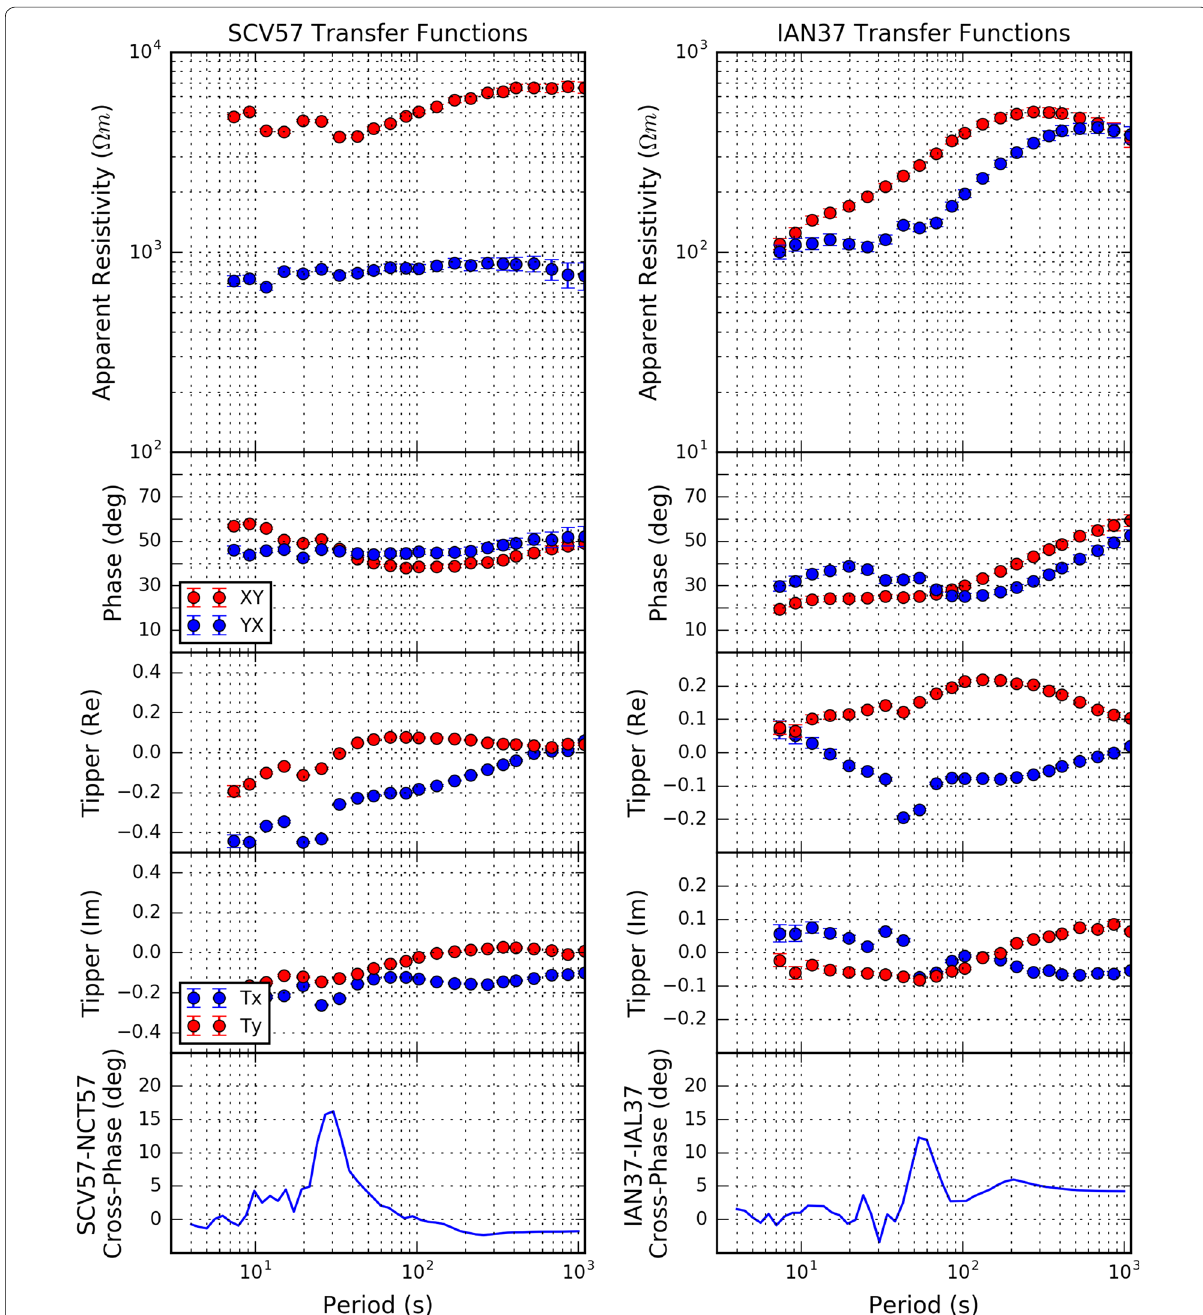
Fig. 2 Transfer functions and cross-phase analyses from sites shown in Fig. 1. The upper four plots in each column display the robustly estimated remote reference TFs for the indicated site. TF estimates were calculated with EMTF (Egbert and Booker 1986). In each of these plots, blue is used to denote TFs that involve the N–S magnetic field (X geomagnetic component: YX impedance element and Tx vertical field TF component) and red is used to denote TFs that involve the E–W magnetic field (Y geomagnetic component: XY impedance element and Ty vertical field TF component). The bottom plot in each column shows the calculated time-averaged cross-phase spectra for the specified pair of sites for the N–S (X) component of the magnetic field (estimated using the wavelet technique outlined in Waters et al. 2006). (See Additional file 1: Fig. S3 for TFs from NCT57 and IAL37; see Additional file 1: Fig. S4 for plots of the full impedance tensor from